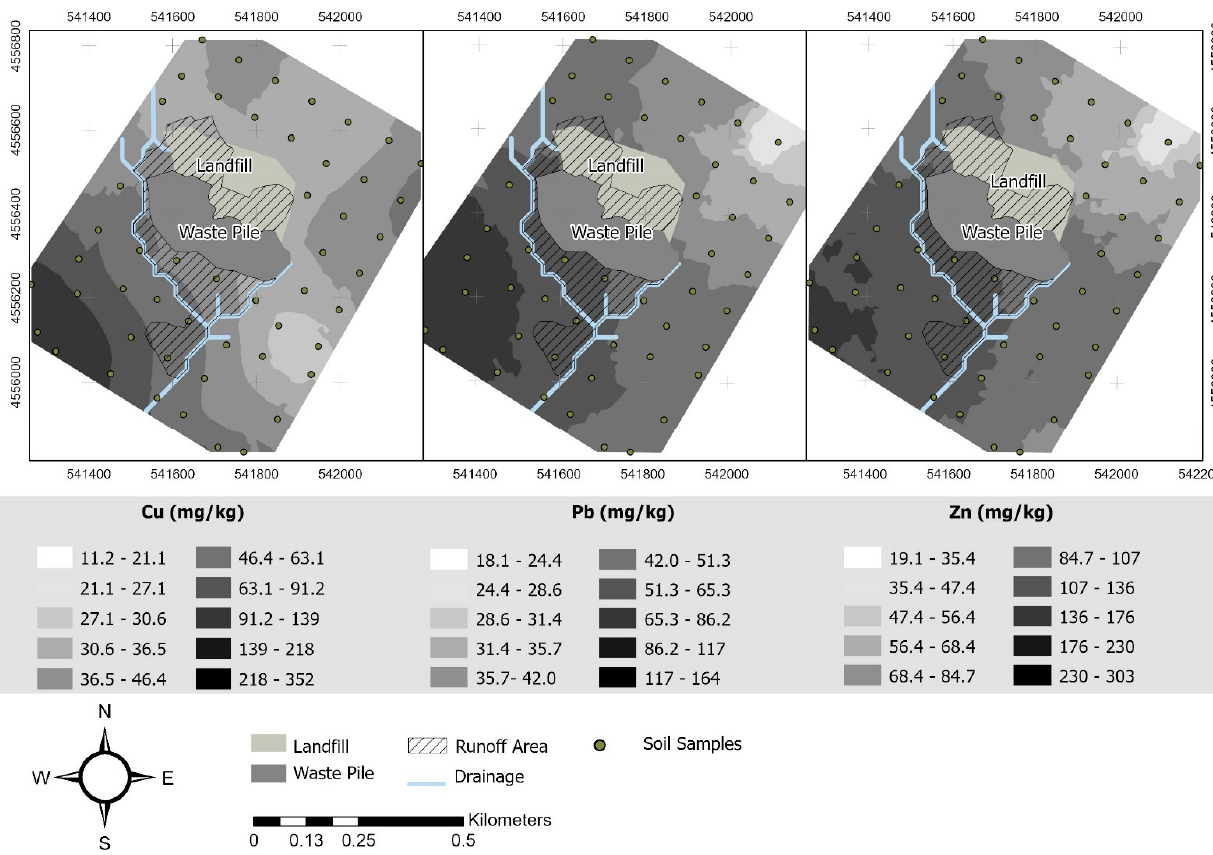
Figure 7. Spatial distribution of Cu, Pb, and Zn in the soils that surround São Pedro da Cova waste pile, interpolated by ordinary kriging. pile, interpolated by ordinary